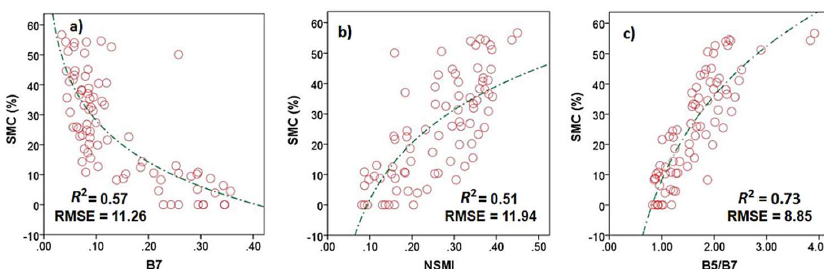
Figure 5. The fit-curve regressions of SMC and R rs ( λ ) corresponding to: ( a ) the L8 SWIR-2 band, B7; ( b ) NSMI (calculated by (B6 − B7)/(B6+B7)); c ) the L8 spectral ratio of the NIR band (B5) versus the SWIR-2 band, B5/B7, using data measured from 80 soil sub-samples. The best fit of the exponential curve to the relationship of SMC and B5/B7, which is ( c ) indicates the appropriateness of this band ratio for estimating SMC by using L8 data.